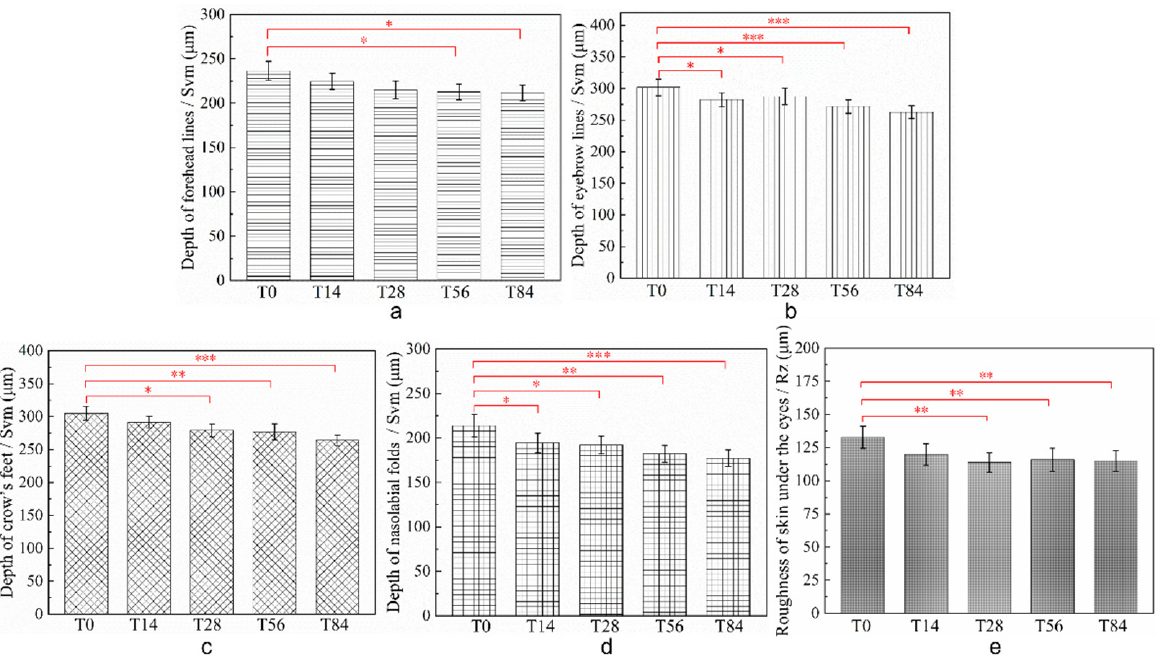
Figure 8. After 84 days of continuous treatment with CP-DMNs in different test areas: forehead lines ( a ); eyebrow lines ( b ); crow’s feet ( c ); nasolabial folds ( d ); and under-eye fine lines ( e ); the subjects’ wrinkle depth or skin roughness at a specific time point. The significant threshold of p < 0.05, p < 0.01, p < 0.001 are marked with *, ** and ***, respectively.